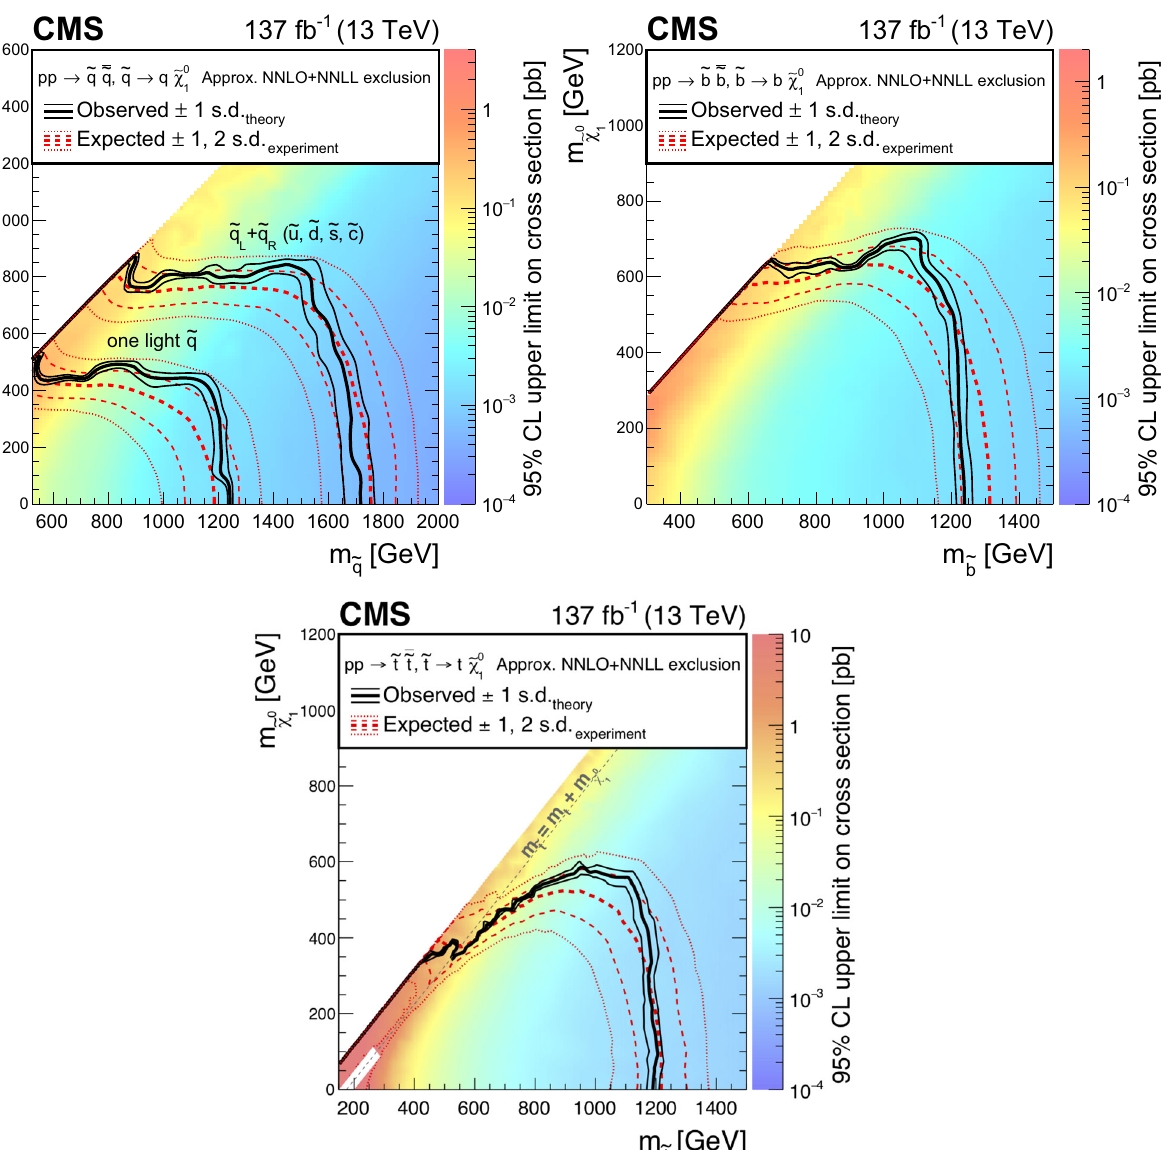
| m ˜ − m − m | < 25 GeV and small m . Here the efficiency of the ˜ χ 0 ˜ χ 0 t t 1 1 − m , and as a result the precise selection is a strong function of m ˜ ˜ χ 0 t 1 determination of the cross section upper limit is uncertain because of the finite granularity of the available MC samples in this region of the , m ( m ˜ ) plane. In the same exclusion limit, the dashed black diagonal ˜ χ 0 t 1 = m + m line corresponds to m ˜ . Signal cross sections are calculated ˜ χ 0 t t 1 atapproximatelyNNLO+NNLLorderin α S [136–147],assumingunity branching fraction for the indicated decay